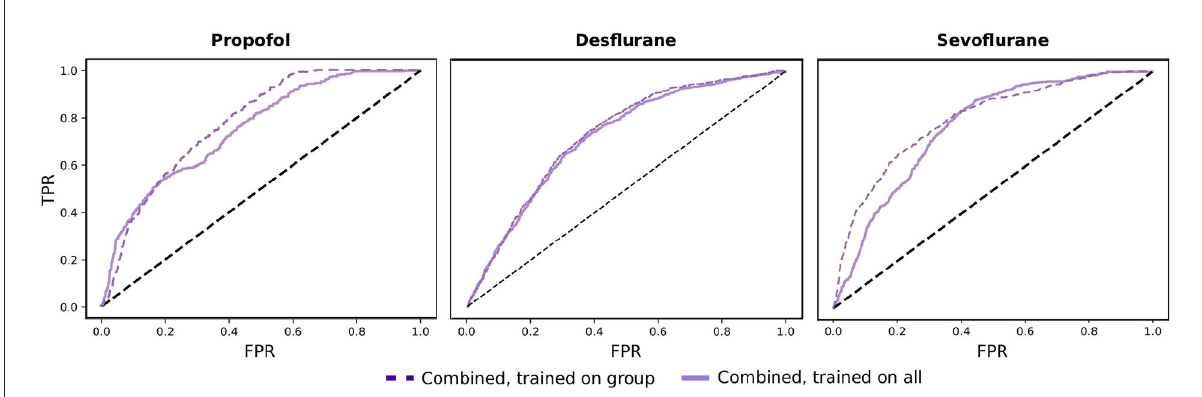
FIGURE5 Comparison of combined risk evaluation. Results shown for Propofol, Desflurane, and Sevoflurane comparing the combined risk evaluation when the classifiers are trained on the corresponding medical group and when they are trained on the whole data